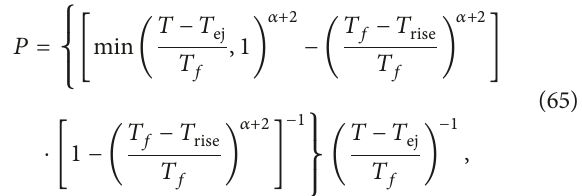
. (Figures after Willingale et al. [108]; see Figure 16 peak